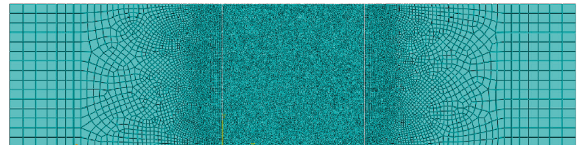
Figure 13: Three-point bending concrete beam model mesh.